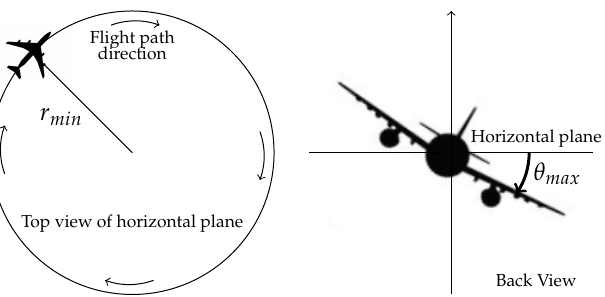
Figure 8. Link between the maximal bank angle and the minimal curvature